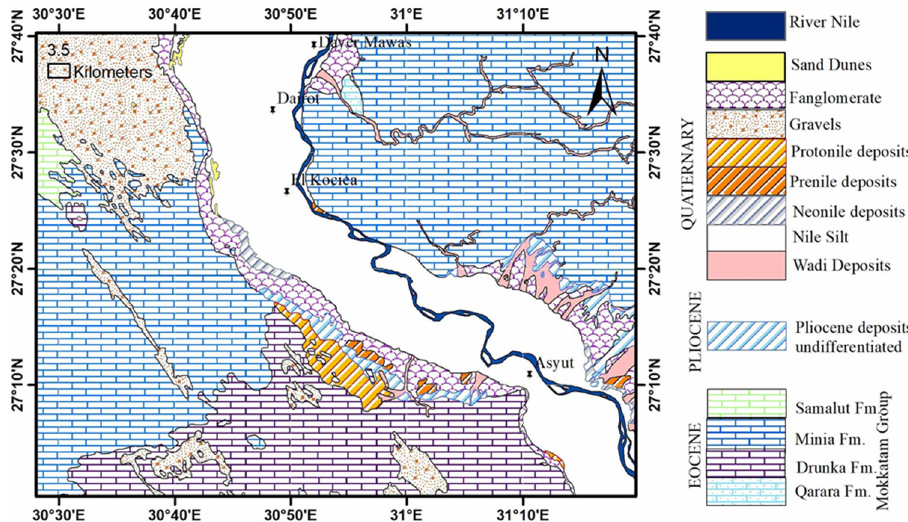
Figure 1. Location map of the study area.